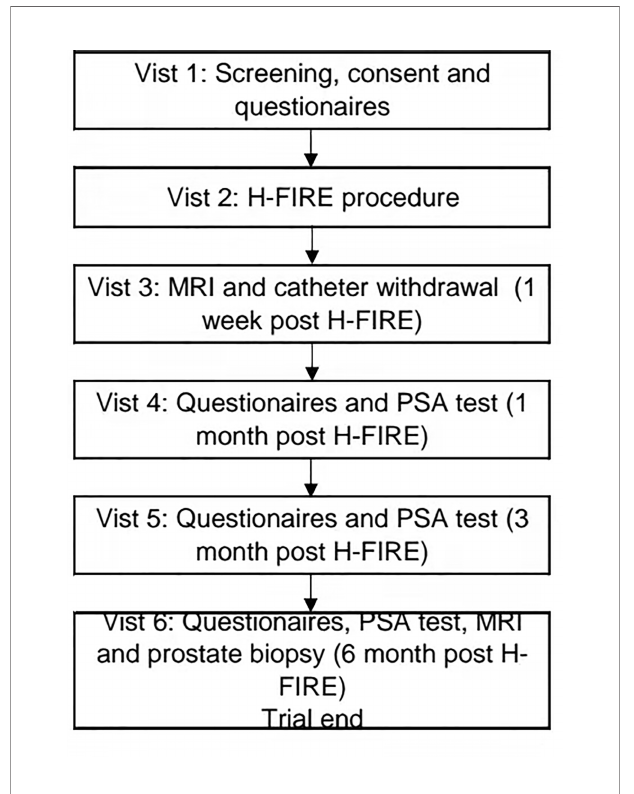
FIGURE 1 | Trial fl owchart.